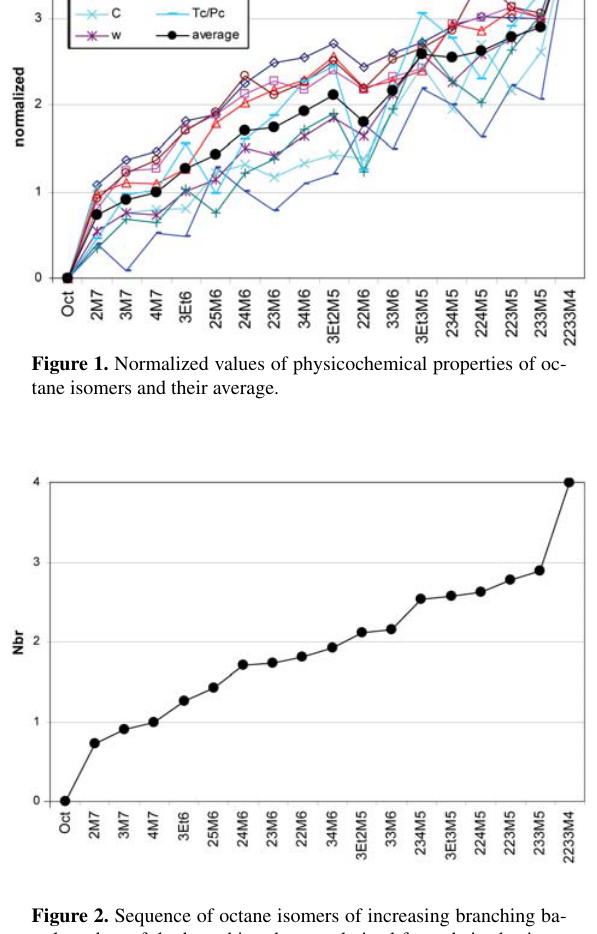
Figure 2. Sequence of octane isomers of increasing branching ba- sed on data of the branching degrees derived from their physicoc- hemical properties. The sequence of branching degrees of octane iso-